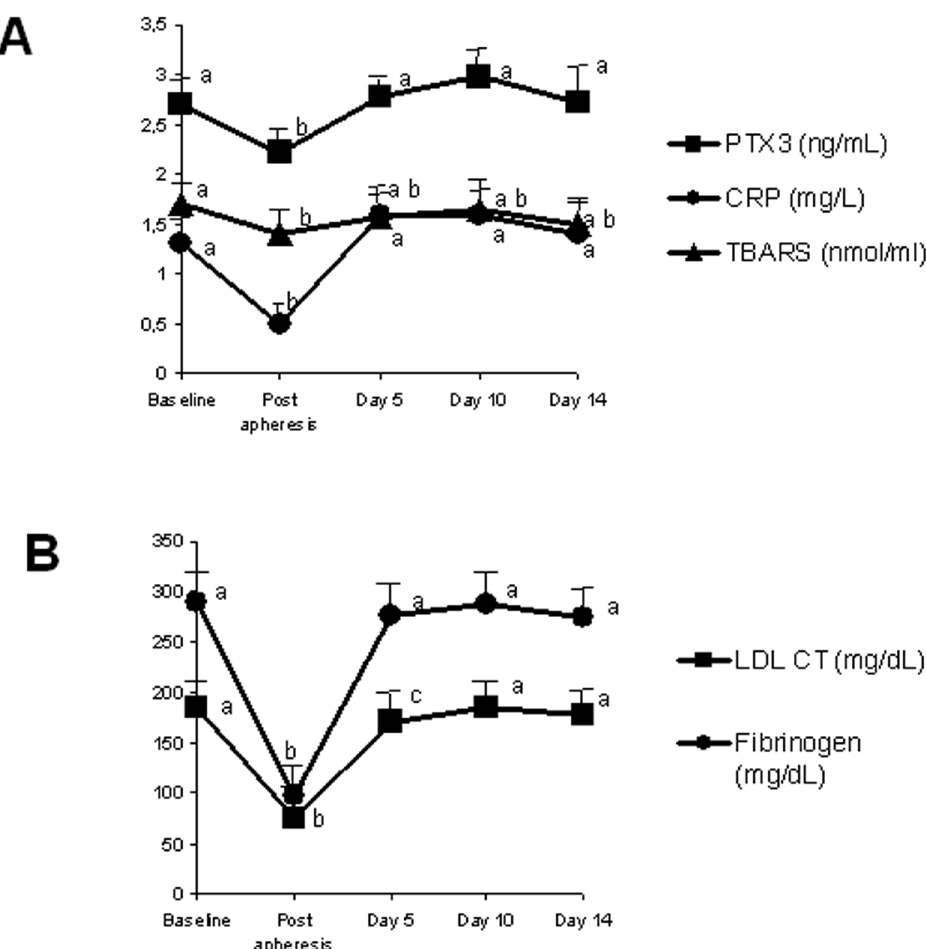
Figure 3. Fourteen-days trend analysis of pre- and post-treatment A) PTX3, CRP and TBARS plasma levels and B) LDL-cholesterol (LDL-CT) and fibrinogen in nine patients on chronic HELP LDL-apheresis. Within each curve, values sharing the same superscript letter do not differ significantly (P , 0.05).